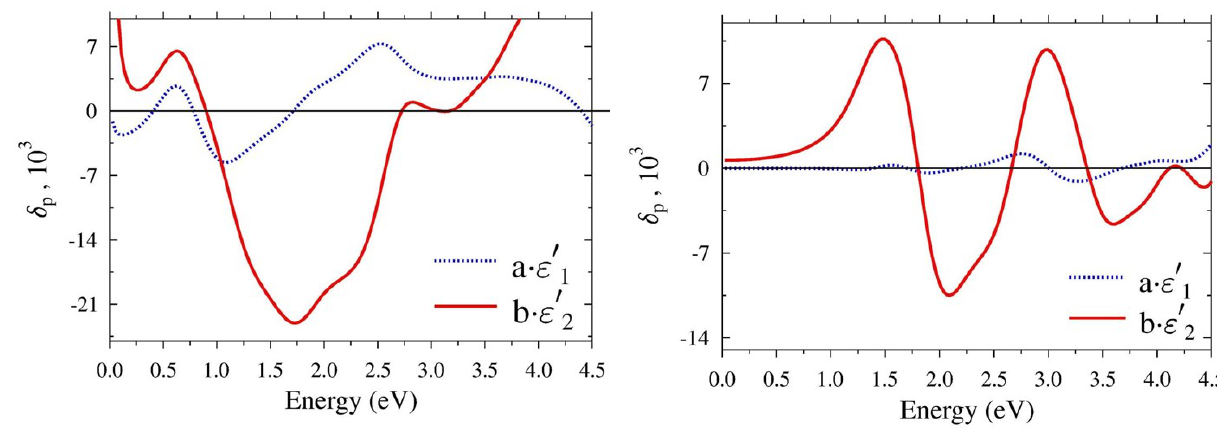
Fig. 4. Left (14% Co) and right (28% Co) panels show decomposition of δ p into the sum of products (see Eq. (1)). Angle of light incidence φ = 68 ◦ .